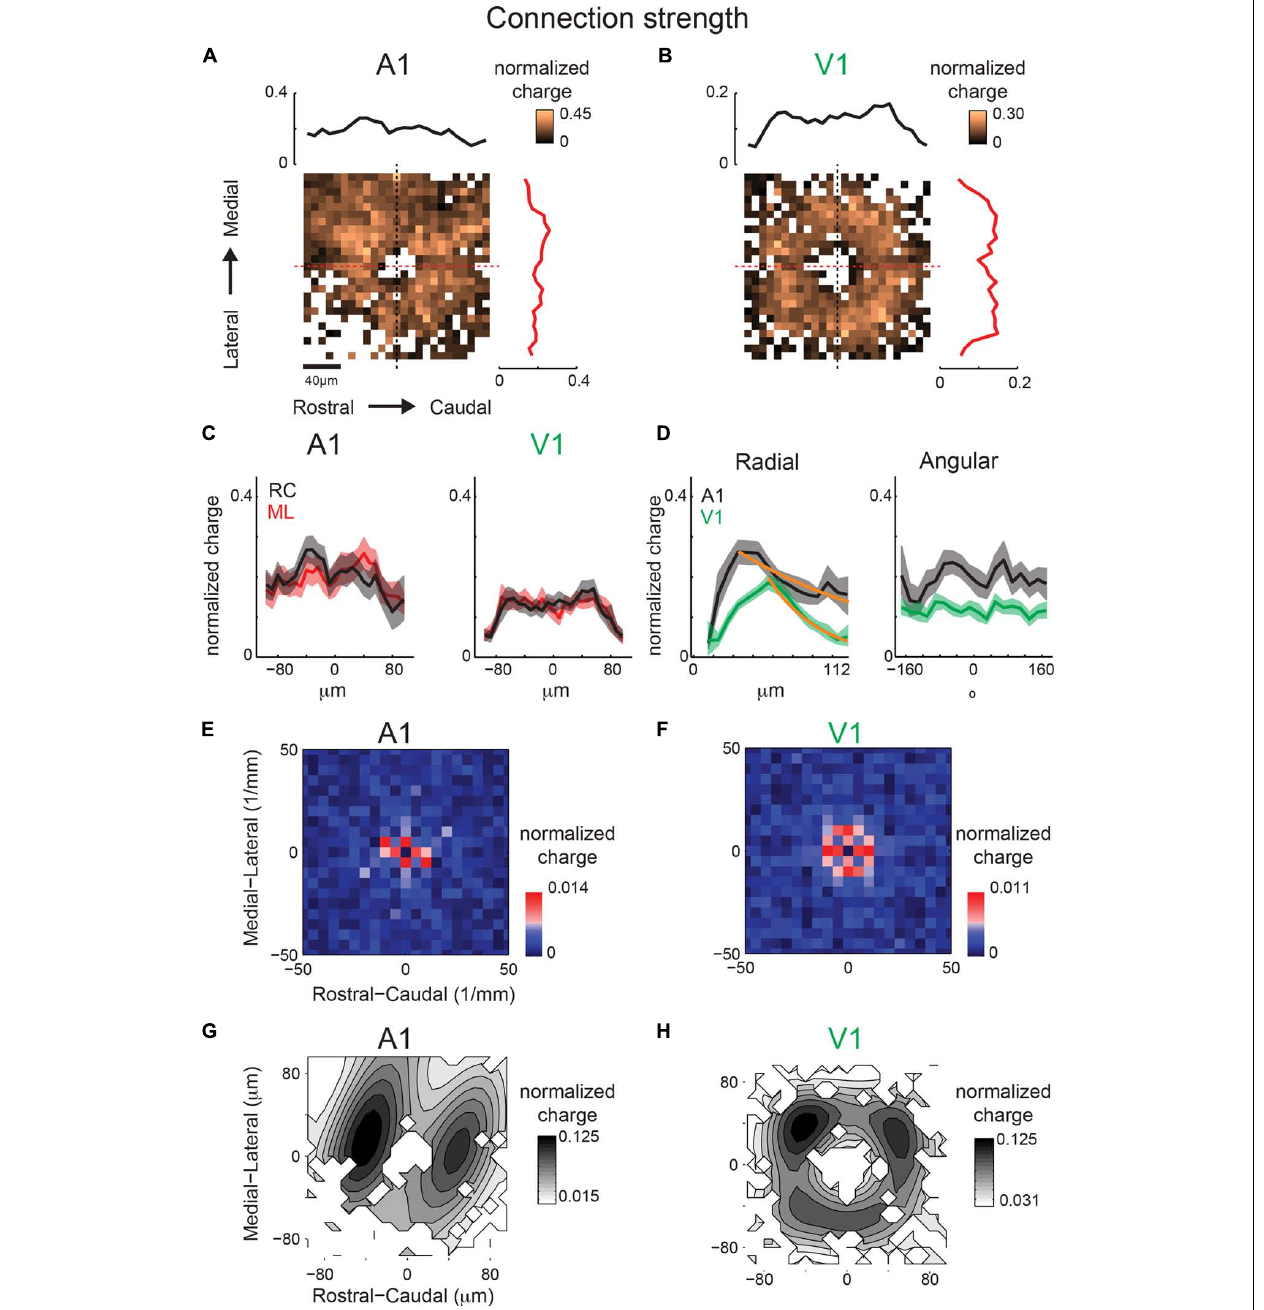
FIGURE 11 | Mean inhibitory IPSC strength maps from the same population of neurons as in Figure 10 show consistent trend with connection probability. Mean maps from the population of A1 (A) andV1 (B) recorded neurons demonstrating profile of strength of inhibitory inputs in both A1 andV1. Plots above and to the right of the mean map indicate the marginal profile along the ML (isofrequency) and RC (tonotopic) directions respectively. (C) ML and RC marginals from (A,B) overlaid for A1 (left) andV1 (right). Radial dropoff of mean strength (D) shows the same trend as mean connection probability – a steeper decay inV1 relative to A1 (spatial exponential decay constants of λ = 43 μ m and λ = 138 μ m, respectively), although the peak for